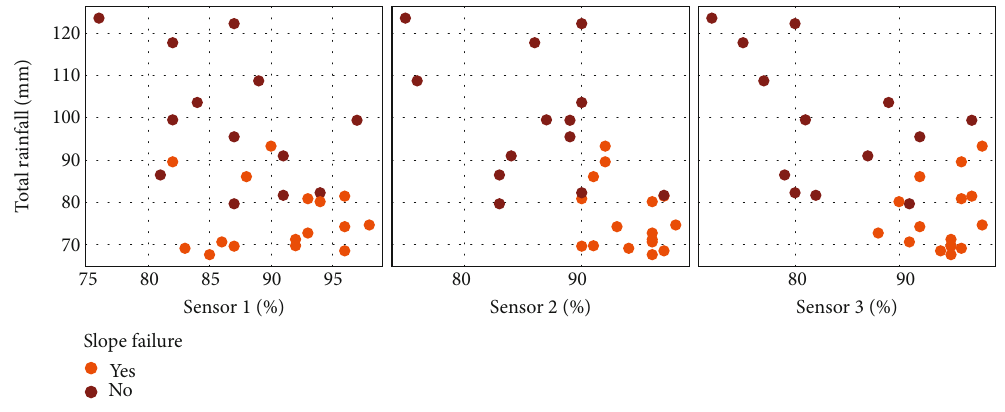
Figure 15: Rainfall and soil moisture